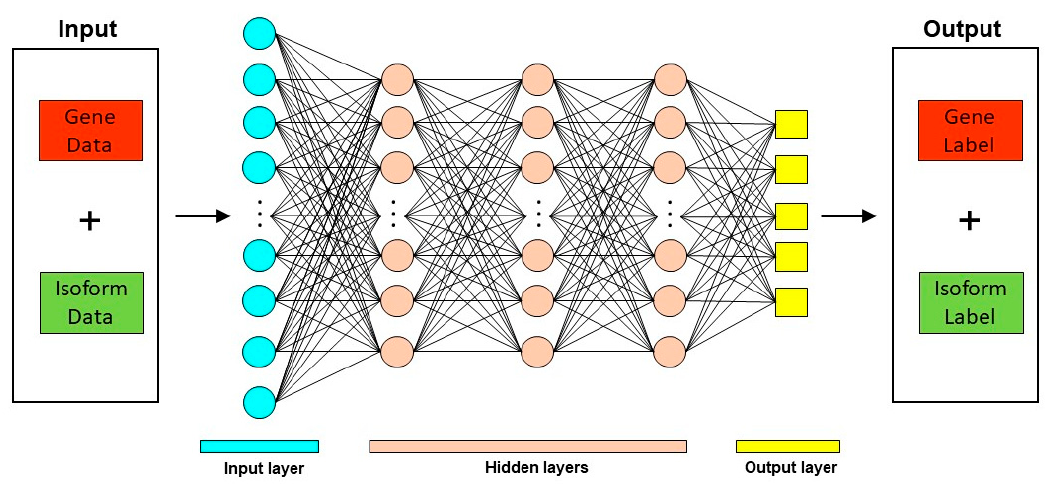
Figure 3. Deep Learning approach for mRNA isoform function prediction. In these methods, gene and mRNA isoform level features are used as input to a deep neural network which consists of multiple hidden layers. The output from these deep neural networks are the predicted gene and mRNA isoform level function predictions.